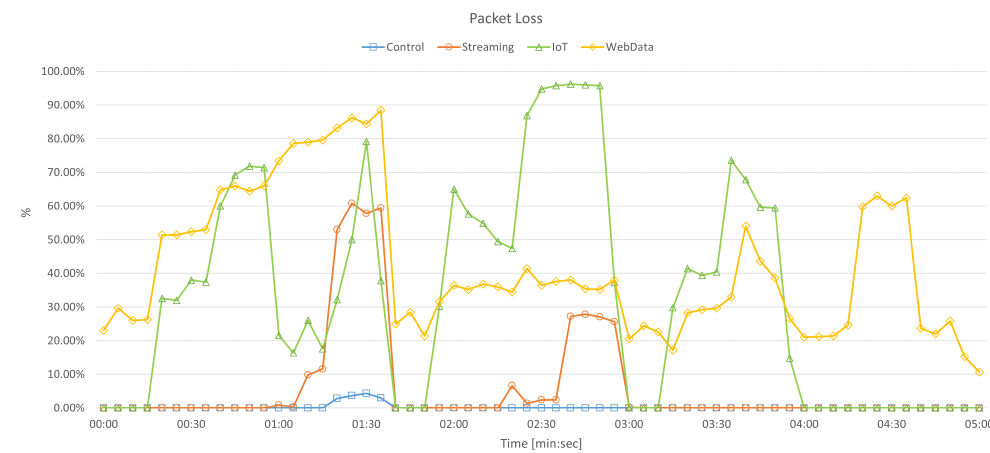
Figure 10. Packet loss obtained from the scenario using the first